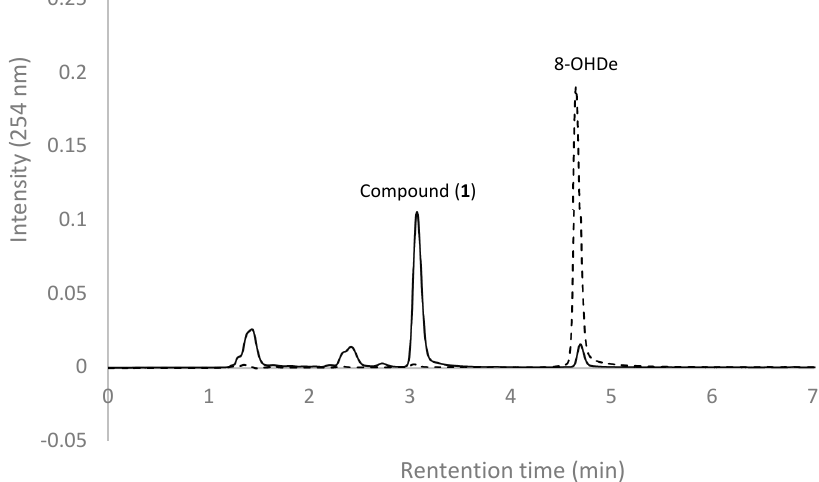
Figure 2. Biotransformation of 8-OHDe with DgAS. The reaction mixtures at 0 min (dashed line) and 30 min (solid line) were analyzed with UPLC. The UPLC operation conditions are described in Materials and Methods.